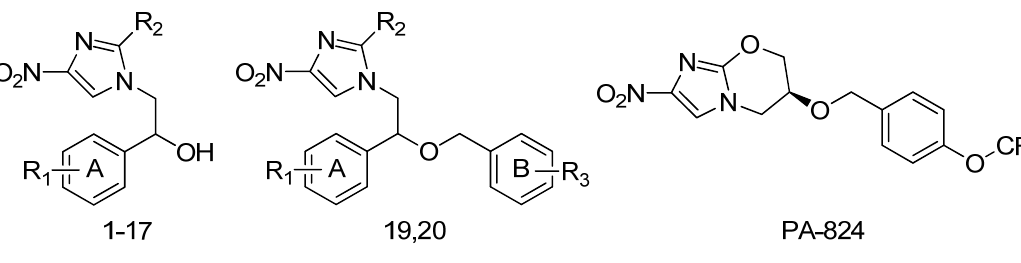
Figure 6. General structures of the monocyclic nitroimidazoles and PA-824( 21